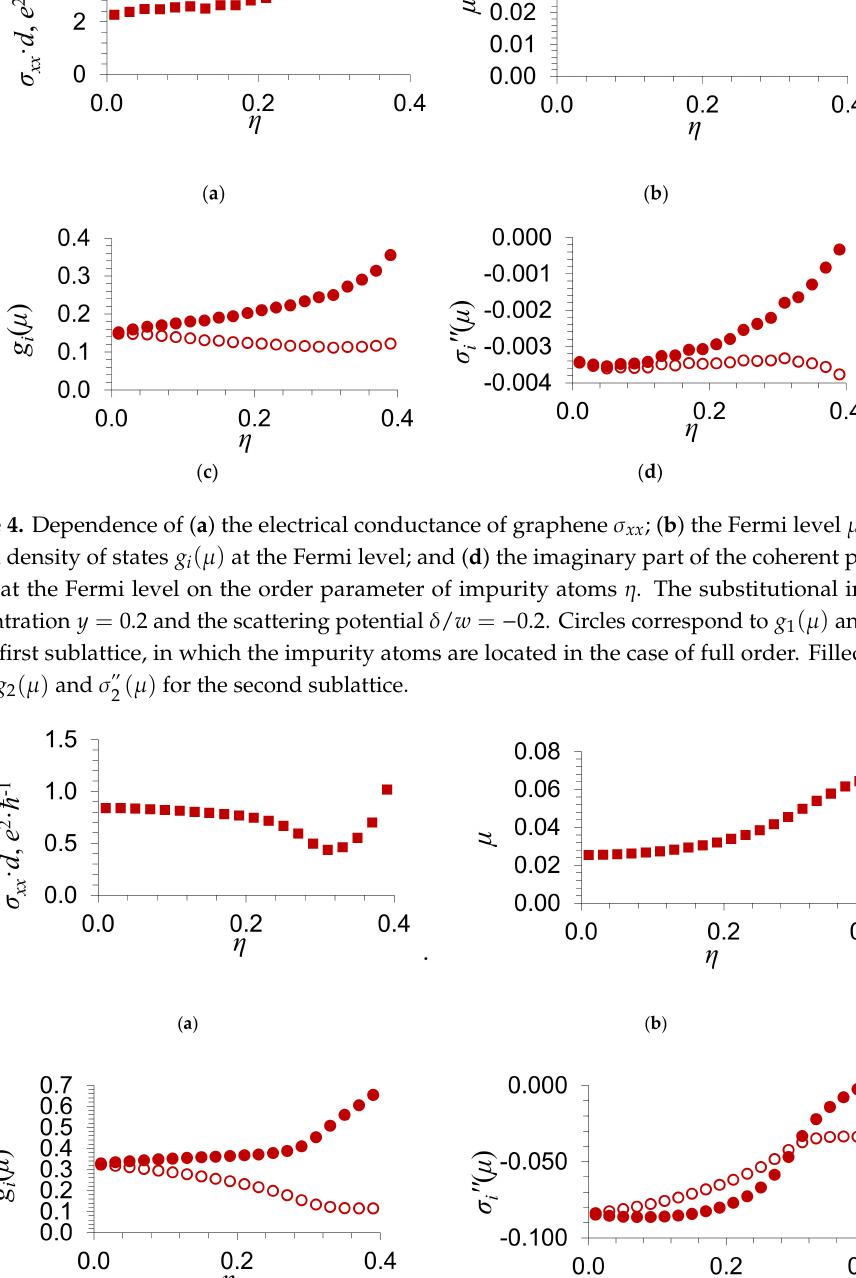
Figure 5. Dependence of ( a ) the electrical conductance of graphene σ xx ; ( b ) the Fermi level µ ; ( с ) the partial density of states g i ( µ ) at the Fermi level; and ( d ) the imaginary part of the coherent potential σ (cid:48)(cid:48) ( µ ) at the Fermi level on the order parameter of impurity atoms η . The substitutional impurity i concentration y = 0.2 and the scattering potential δ / w = − 0.6. Circles correspond to g 1 ( µ ) and σ (cid:48)(cid:48) of the first sublattice, in which the impurity atoms are located in the case of full order. Filled circles ( µ ) for the second show g 2 ( µ ) and σ (cid:48)(cid:48) 2